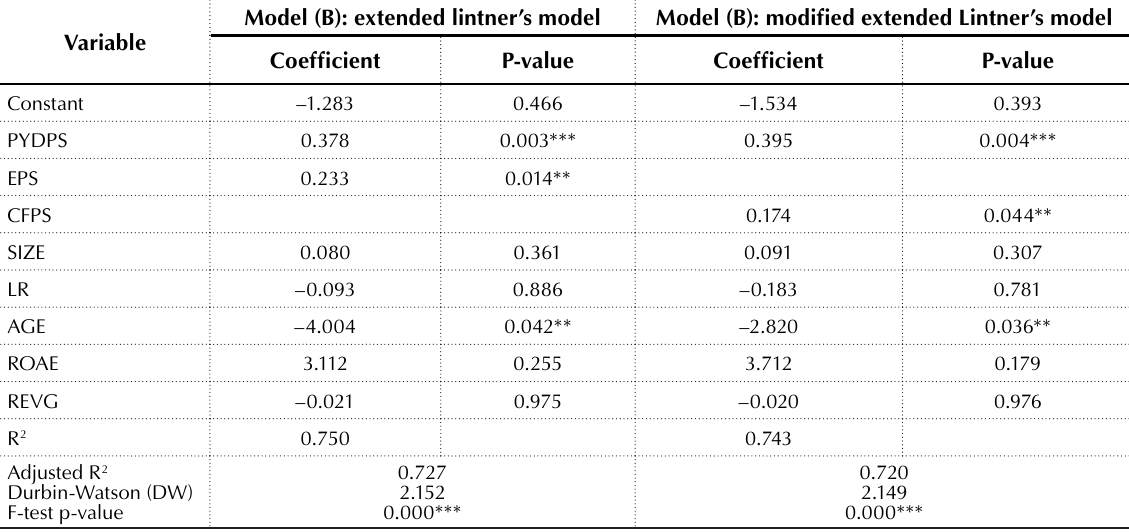
Table 11. Results of Lintner’s extended model (model (B)) and modified extended model (B)